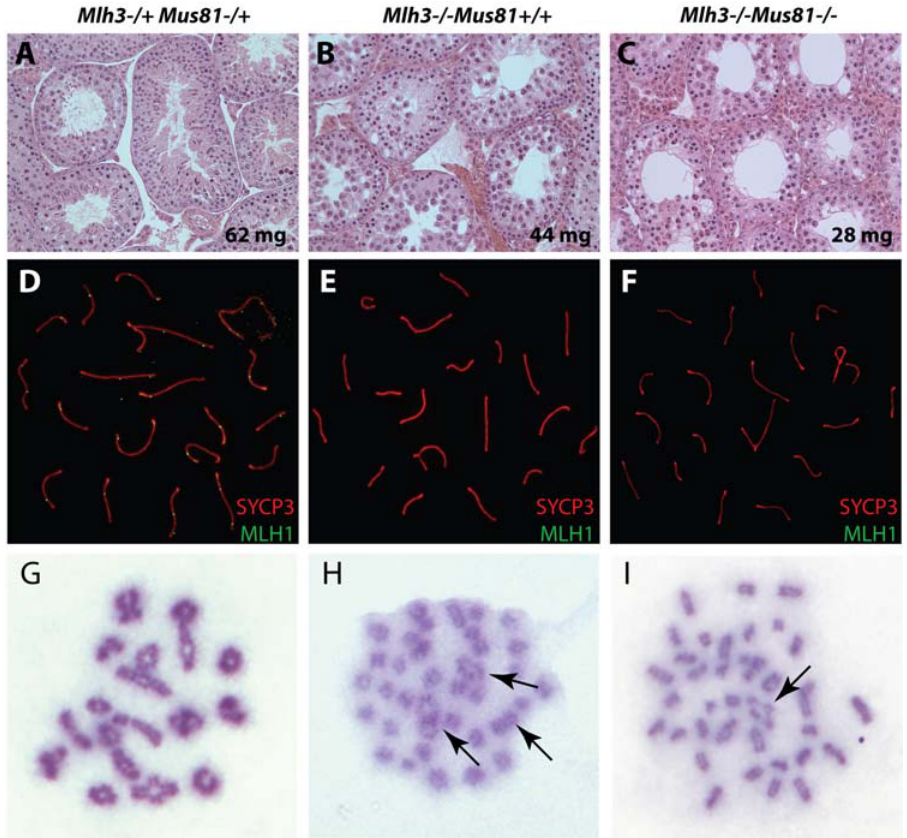
Figure 6. Analyses of Mus81 2 / 2 /Mlh3 2 / 2 double null mice. Mlh3 2 / + :Mus81 2 / + (A), Mlh3 2 / 2 :Mus81 + / + (B) and Mlh3 2 / 2 :Mus81 2 / 2 (C) testes sections were analyzed by H&E staining. Chromosome spreads from the same mice stained with antibodies against SYCP3 (green) and MLH1 (red) (D– F). Diakinesis spreads show normal levels of chiasmata in the Mlh3 2 / + :Mus81 2 / + mice, reduced levels in the Mlh3 2 / 2 :Mus81 + / + mice and only a residual level of chiasmata in the Mlh3 2 / 2 :Mus81 2 / 2 double knock-out mice (G–I). Arrows show the positions of the residual crossovers.